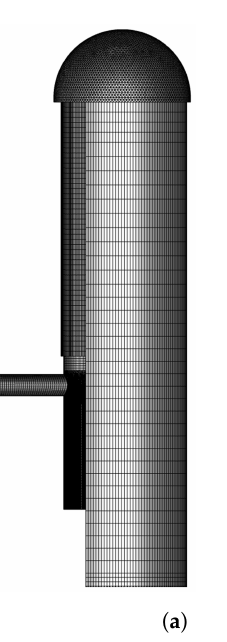
Figure 6. ( a ) Temperature and velocity magnitude extraction line for grid independence test (centre of the combustion chamber), and grid independence test results for ( b ) temperature and ( c ) velocity magnitude profiles.